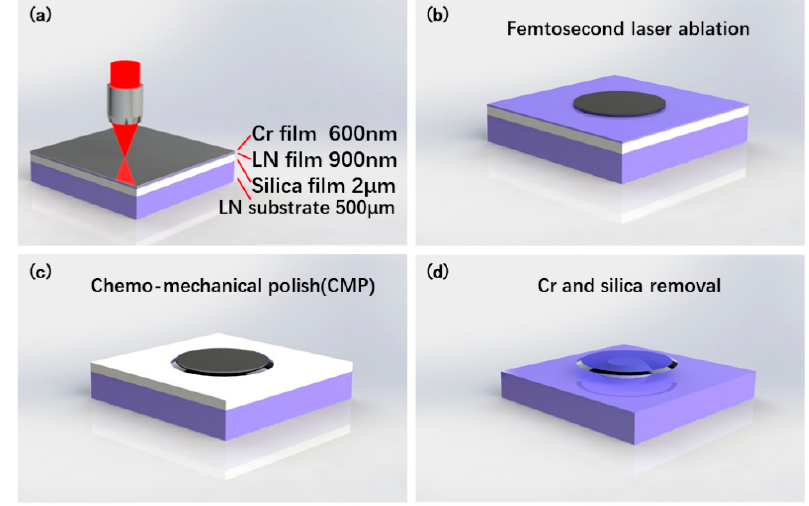
Figure 1. ( a – d ) Flowchart of fabricating an on-chip lithium niobate microdisk